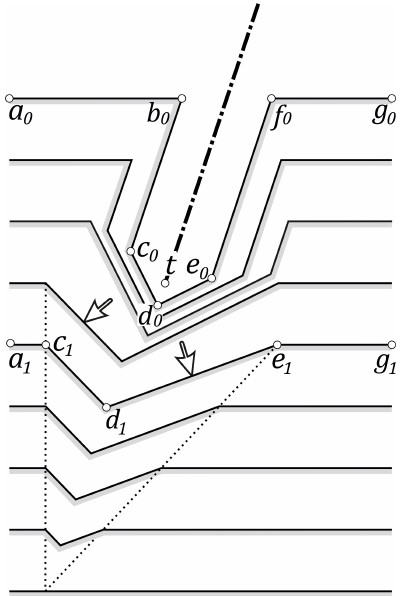
Figure 3. Mechanism of the continuation of an etch pit past the ter- mination of a latent track. Before the advancing surface (a–b–f–g) overtakes the latent track at t , the faces (c–d–e) terminating the track channel have moved ahead, creating a feature that, depending on the etch rates of c–d–e and a–b–f–g, can persist for a time. The duration is extended when, upon intersecting the surface, the intersections a– c–d and d–e–g become convex allowing faster etching orientations to develop (white arrows). This mechanism accounts for the ob- served increases in the track counts in P00 and B60 within the etch model of Jonckheere et al. (2019, 2022) and Aslanian et al. (2021).